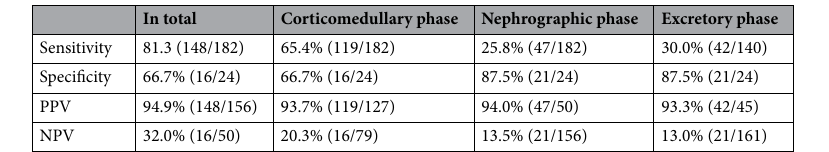
Table 2. Detection of peritumoral pseudocapsule on each phase imaging of contrast enhanced CT. PPV positive predictive value, NPV negative predictive value.